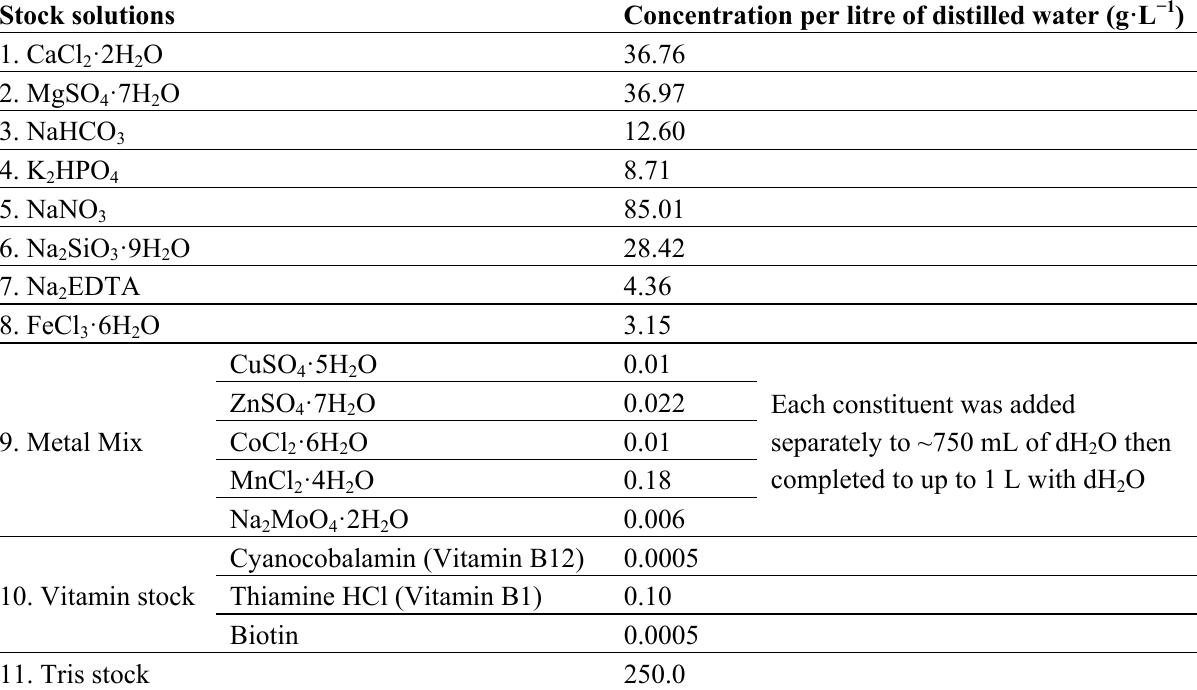
Table 1. Components of the MBL